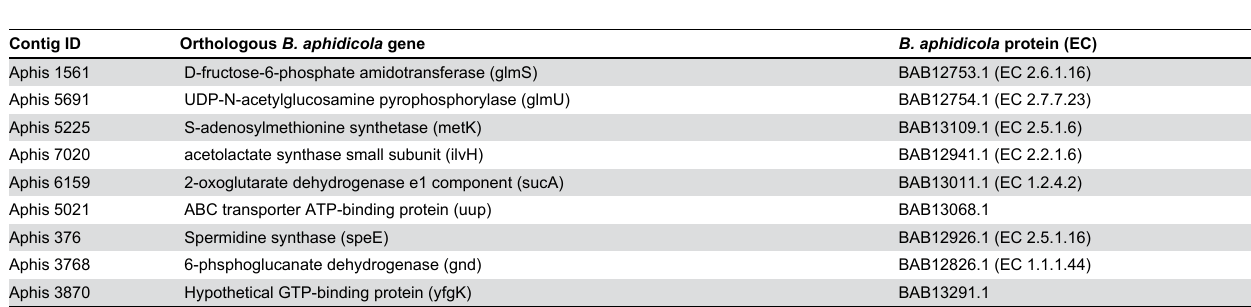
Table 2. The orthologs of A. craccivora contigs derived from the genome of the primary aphid endosymbiont, B. aphidicola (identified in GenBank accession BA000003.2.).